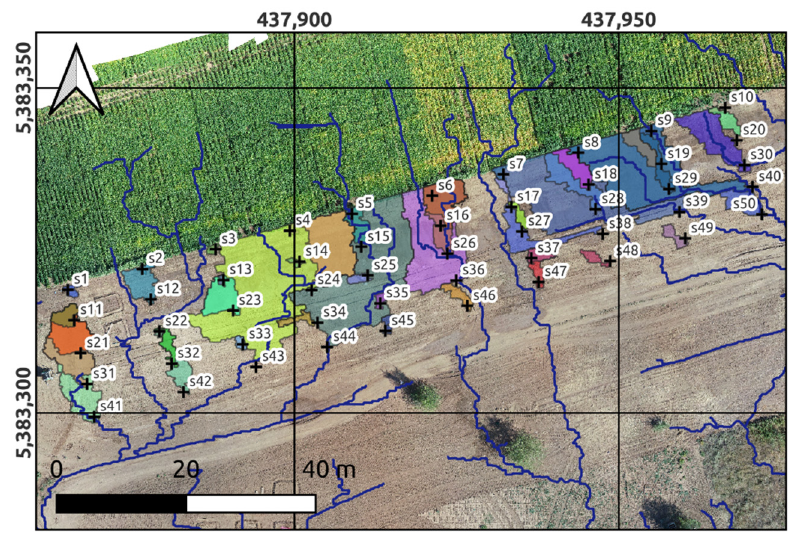
Figure 4. Digital hydrological model of the test plot, including the surface model, synthetic stream networks (blue lines) and its catchments within the test area (polygons).